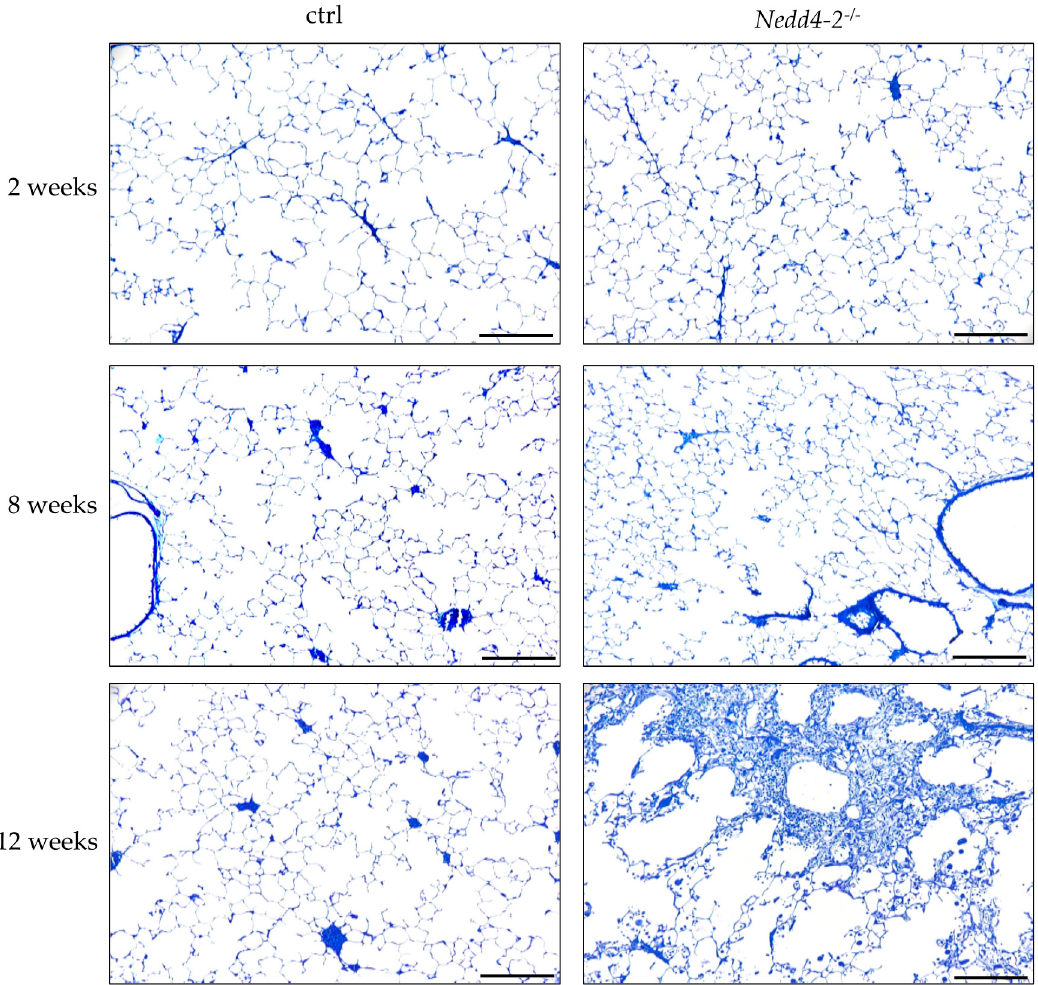
Figure 1. Composition of parenchyma. Representative light microscopic images of control (ctrl) and Nedd4-2 -deficient lungs ( Nedd4-2 − / − ) after 2, 8 and 12 weeks of doxycycline induction. At 12 weeks, septal walls appears thicker, and in some areas, lungs are consolidated by inflammatory infiltrates and fibrosis without recognizable acinar microarchitecture. Scale bar 200 µm.